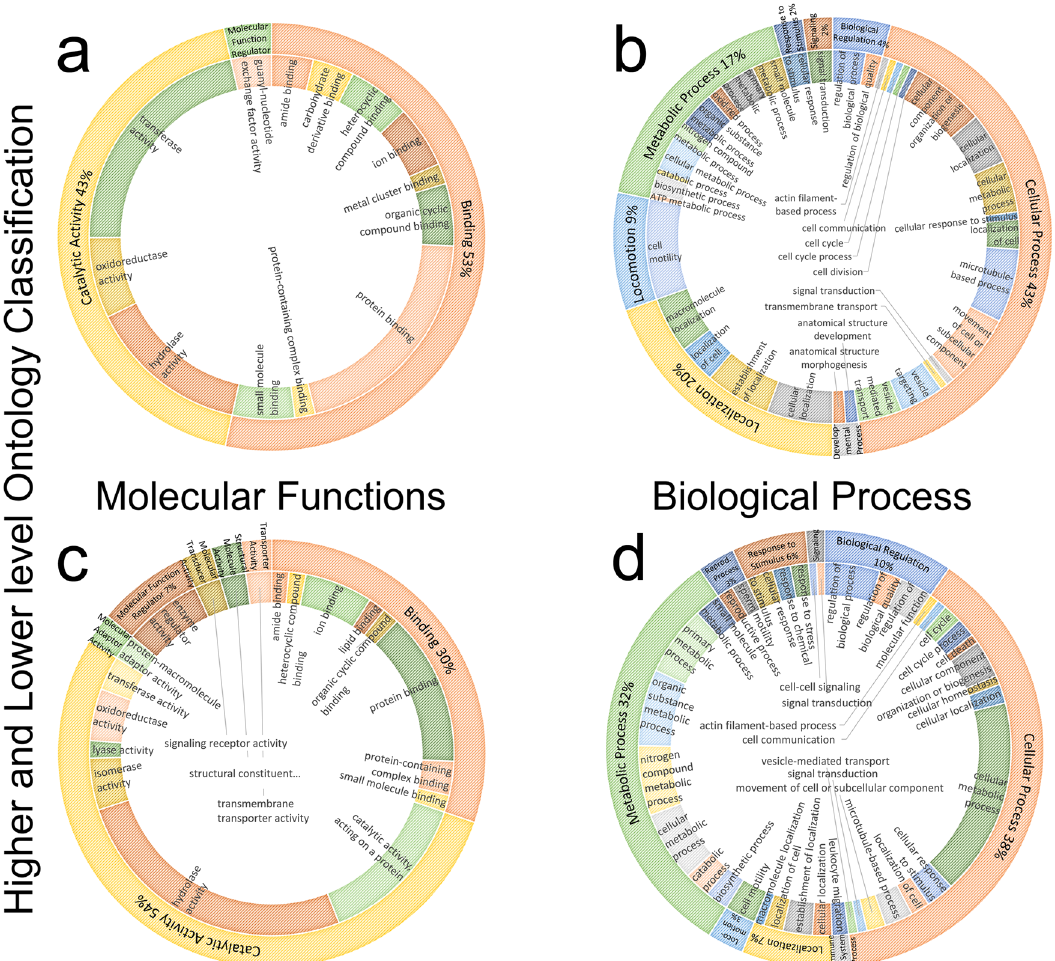
Fig. 4 PANTHER molecular function and biological process analyses of signi fi cantly different zincoproteins after capacitation. Molecular functions ( a , c ) and biological processes ( b , d ), differentiated by their higher abundance ( a , b ) or lower abundance ( c , d ) in zincoproteins found signi fi cantly different by the volcano plot analysis. The outer circle represents high-level ontology classi fi cation (level 0), while the sub-family (level 1, fi ner classi fi cation of categories) is represented by the inner circle of the respective doughnut chart.